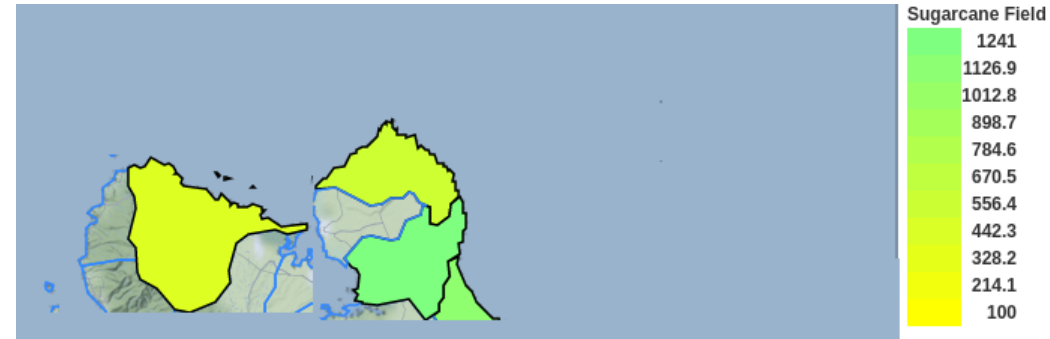
Figure 15. Agricultural data considered at third stage of co-design process